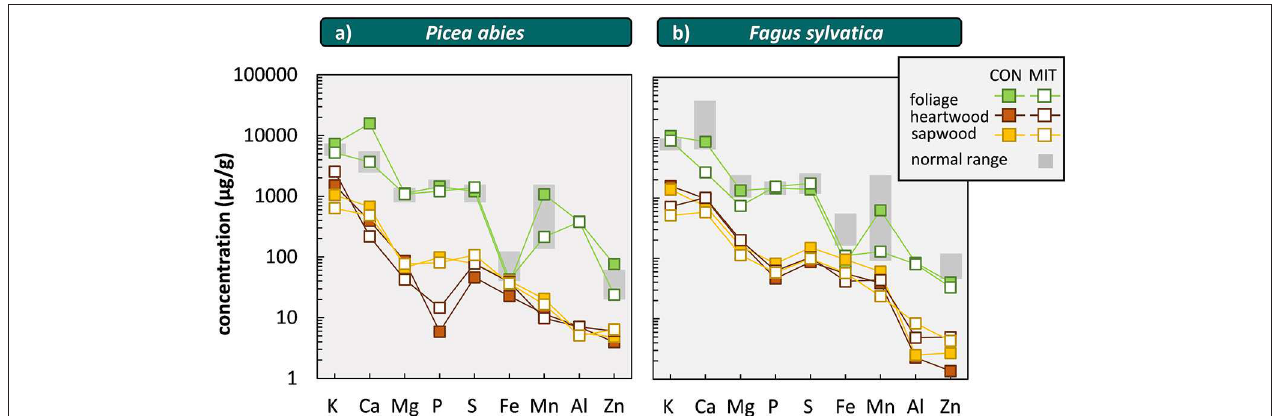
FIGURE 8 | Elemental concentrations in leaves, needles, heartwood (dead part of wood) and sapwood (living part of wood) of Picea abies (a) and Fagus sylvatica (b) at CON and MIT. We did not illustrate data of sample MIT-V-7 and MIT-V-8 as P and S were not analyzed in these samples. “normal range” denotes the critical leaf and needle concentration at normal range [data from Göttlein et al. (2011)]. Elements on x-axis are sorted from left to right by macronutrients, micronutrients, and plant-beneficial